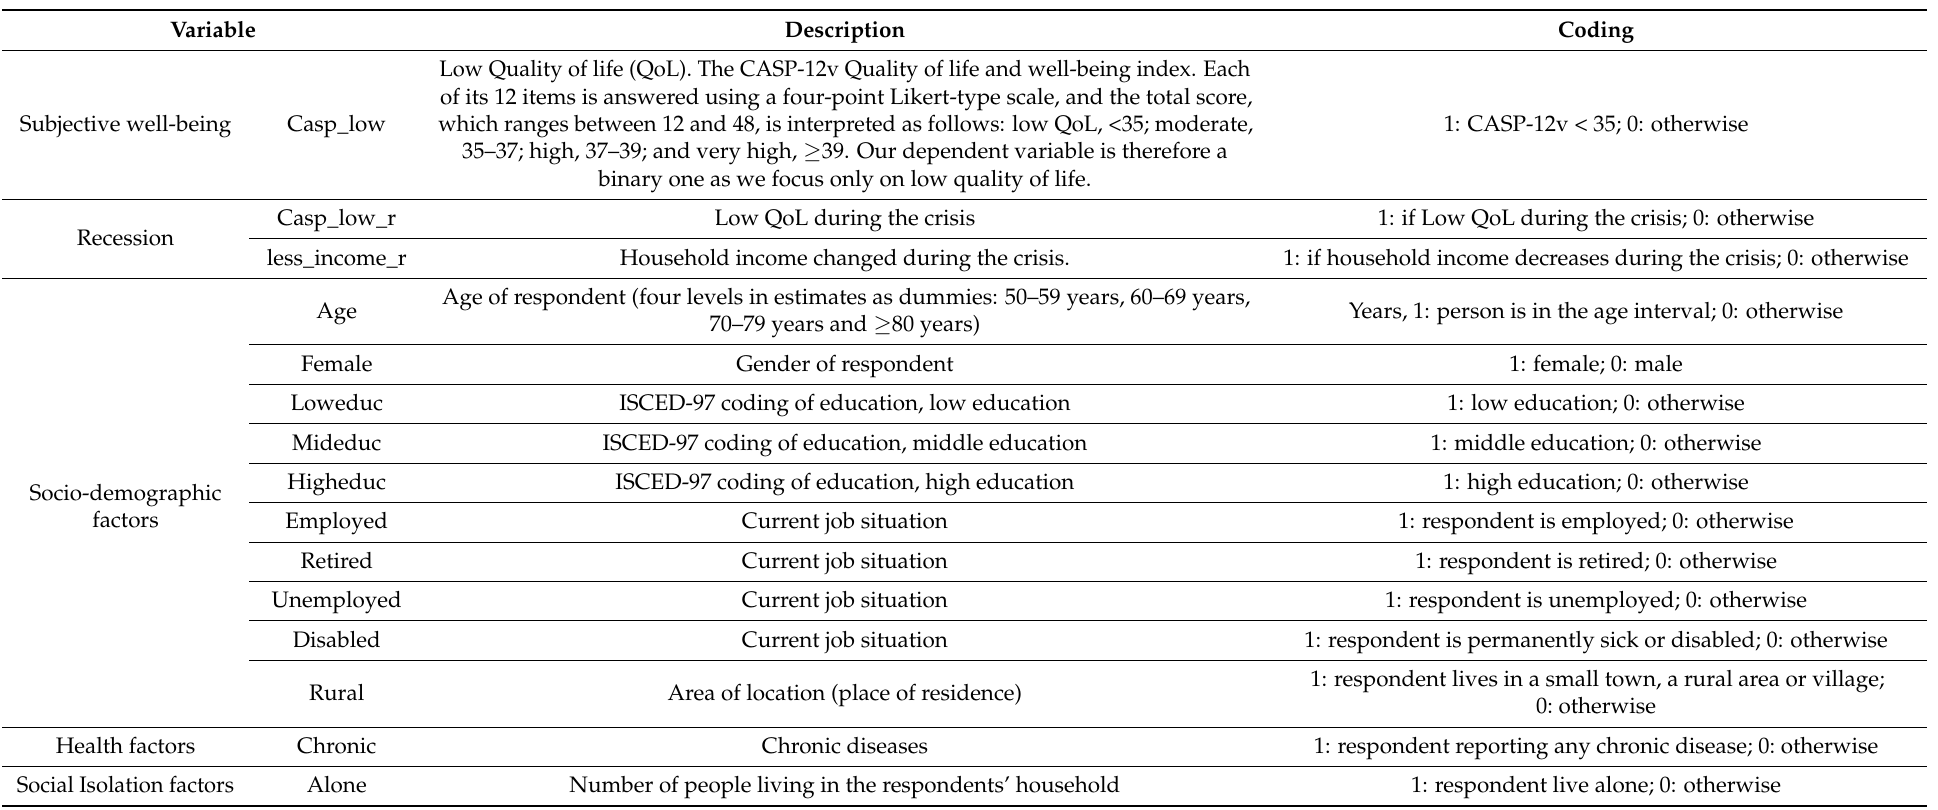
Table 1. Variables used, and their description and